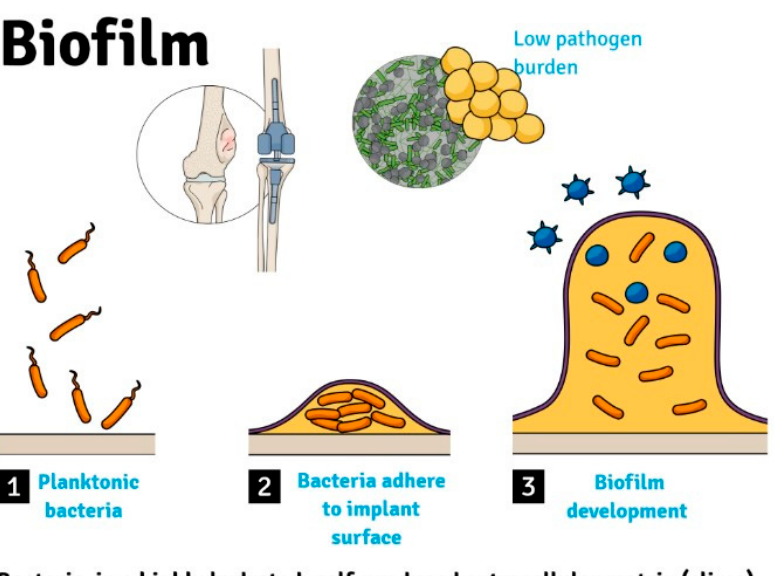
Figure 1. Bacteria adhere to implant surface to develop a biofilm in periprosthetic tumor infections.